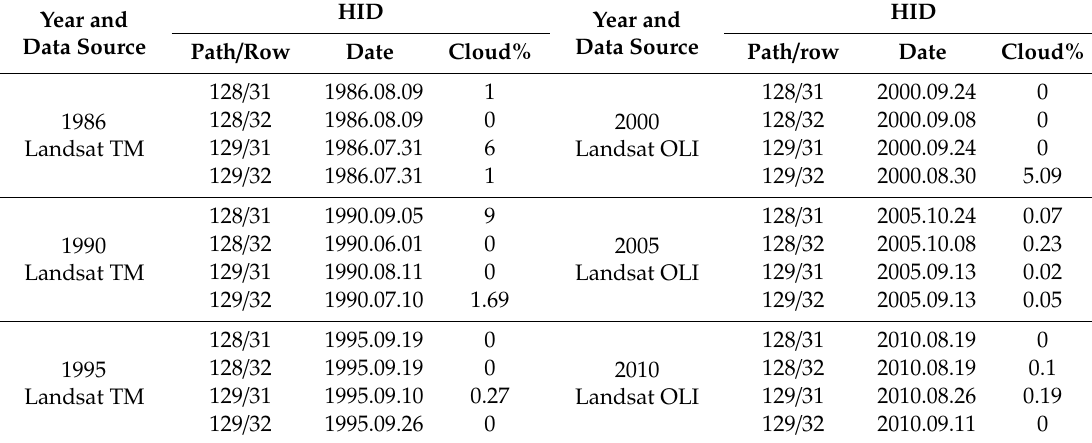
Note: HID represents the Hetao Irrigation